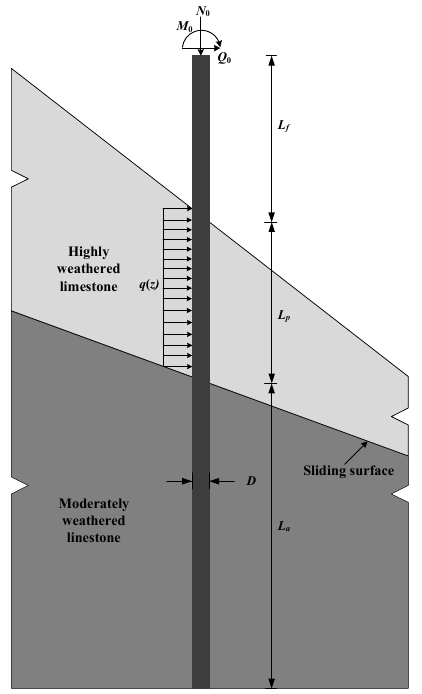
Figure 10. Schematic diagram of engineering case analysis of influence factors. Table 3. Detailed